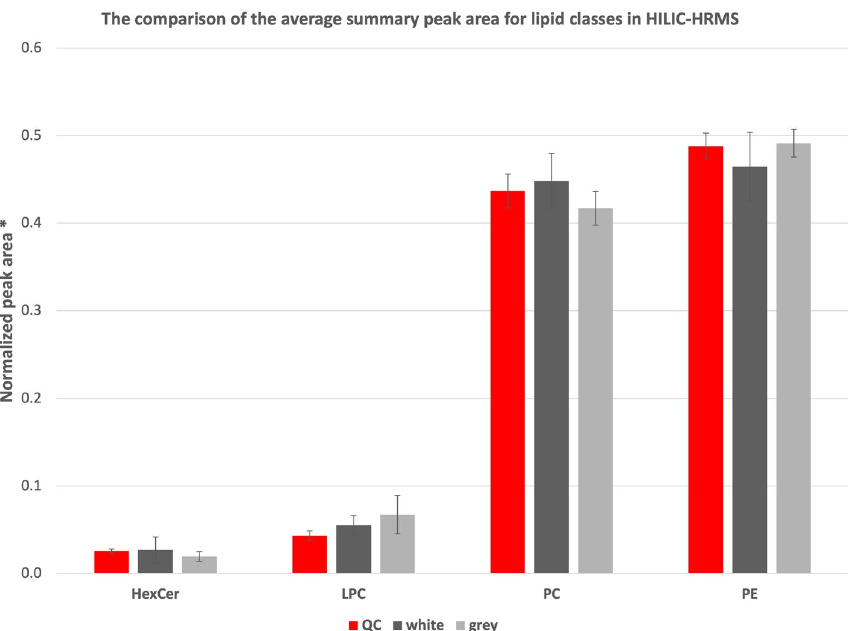
Figure 3. The comparison of the average summary peak area for lipid classes in HILIC-HRMS. Plots with mean normalized peak areas for lipid classes with with whiskers representing standard deviation. *Ratio of the peak area and total peak area for lipids. HexCer —Hexosyl ceramide, LPC —Lysophosphatydylocholines, PC — Phosphatydylocholines, PE —Phosphatydyloetanoloamines, QC —Quality